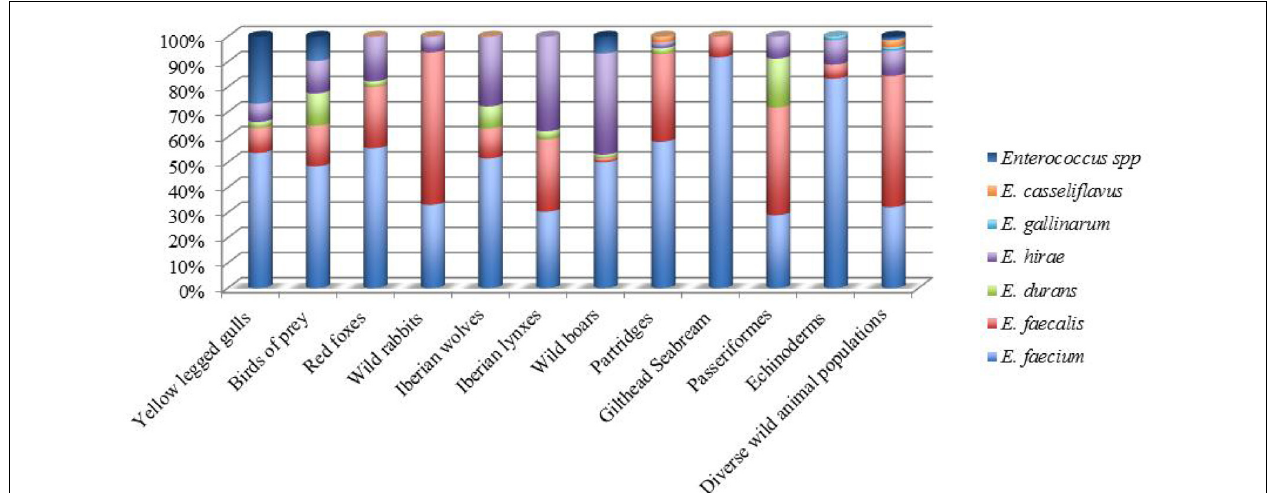
FIGURE 2 | Distribution of Enterococcus species in wild animals from